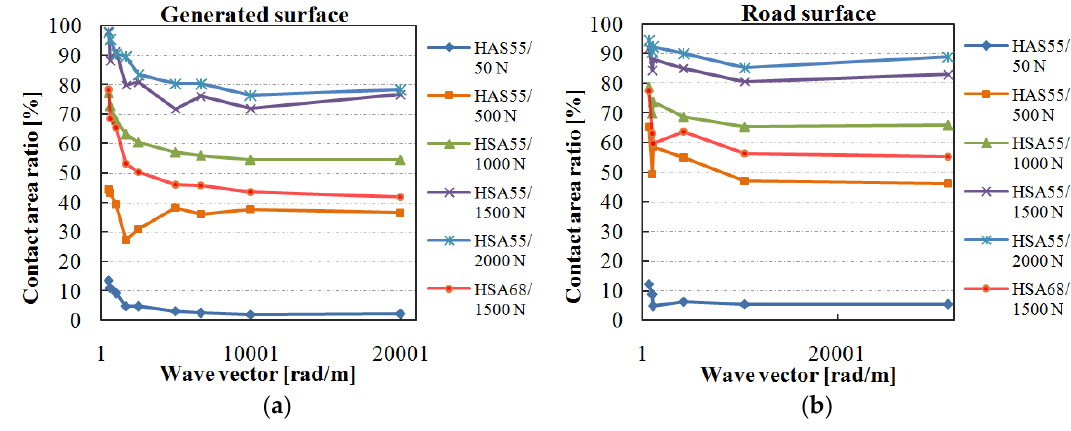
Figure 6. Effect of the observing scale on the contact area between a smooth rubber and ( a ) artificially generated surfaces; ( b ) road surfaces. generated surfaces; ( b ) road